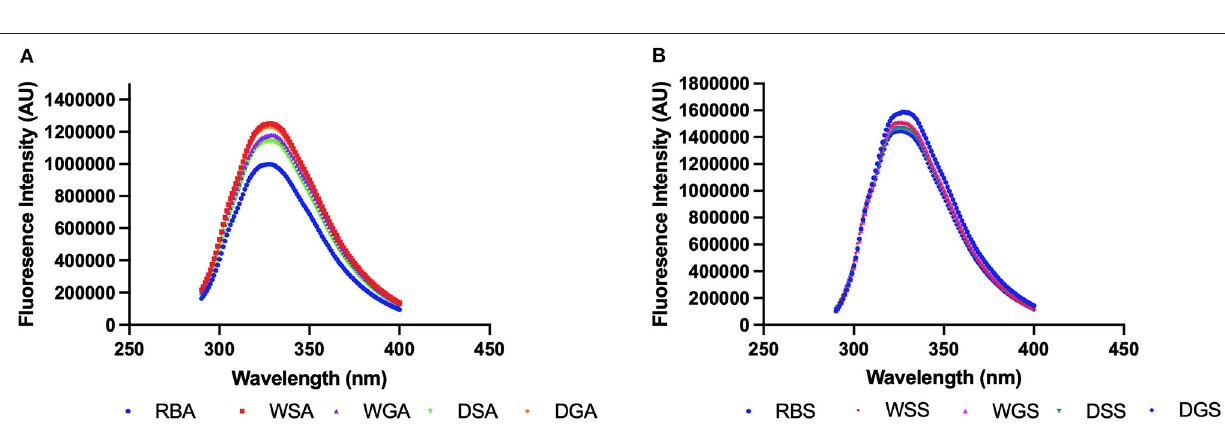
FIGURE 4 | (A) Intrinsic fluorescence measurement of alkaline-extracted protein concentrates and (B) salt-extracted protein concentrates prepared from untreated and pre-treated Yellow Eye beans (0.2 mg/mL in 10mM phosphate buffer, pH 7.2) ( n =